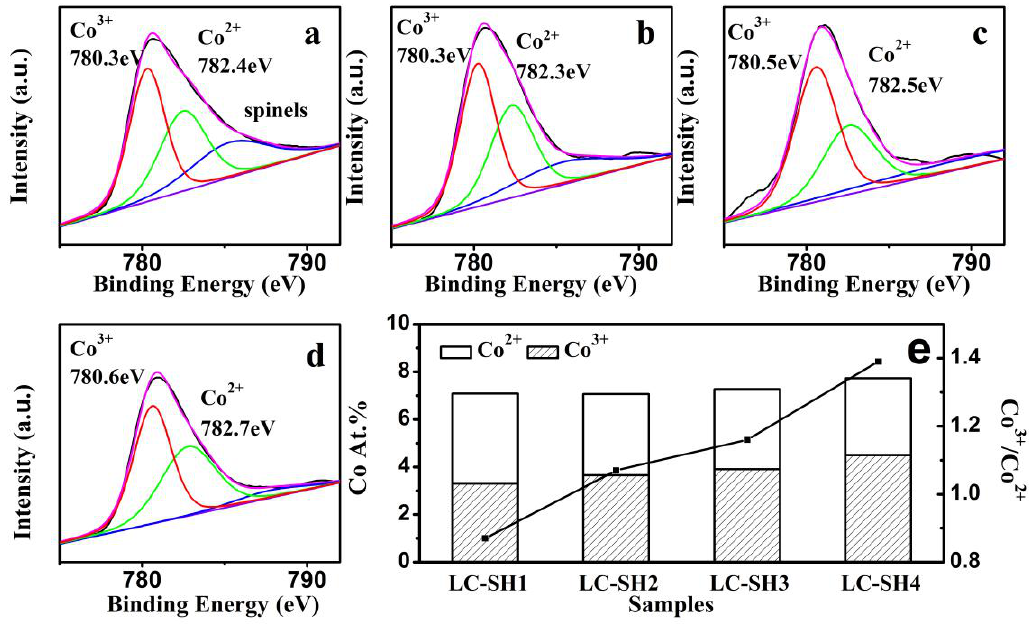
Figure 9. Co 2p XPS spectra of catalysts with different amounts of nitrogen. ( a ) LC-SH1; ( b ) LC-SH2; ( c ) LC-SH3; and, ( d ) LC-SH4.